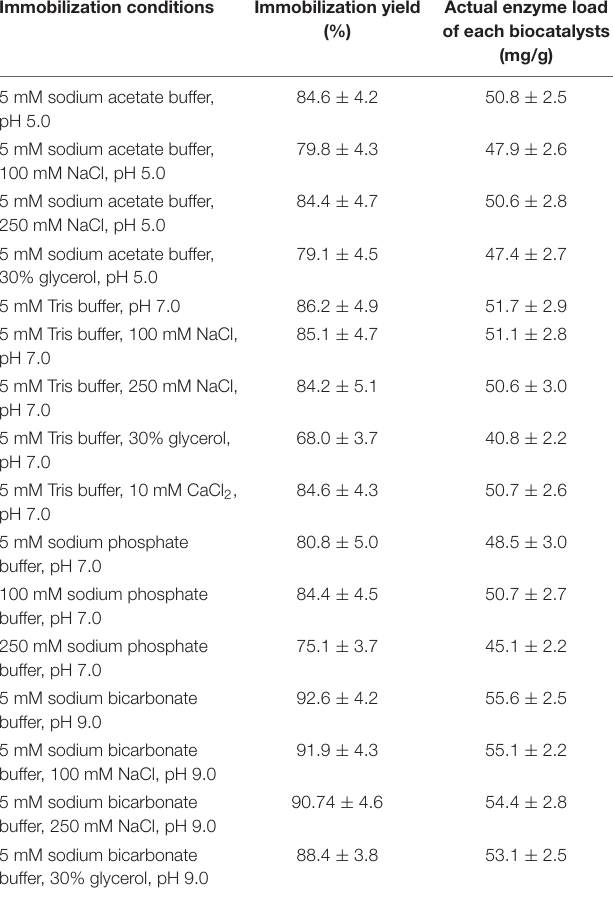
TABLE 2 | Immobilization yield and final loading of the highly loaded PFL biocatalysts prepared under different